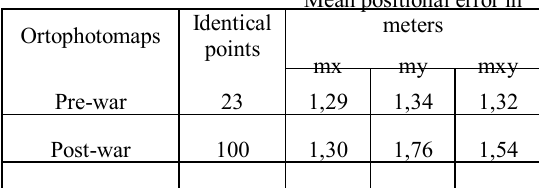
Table 3. Mean positional error in meters